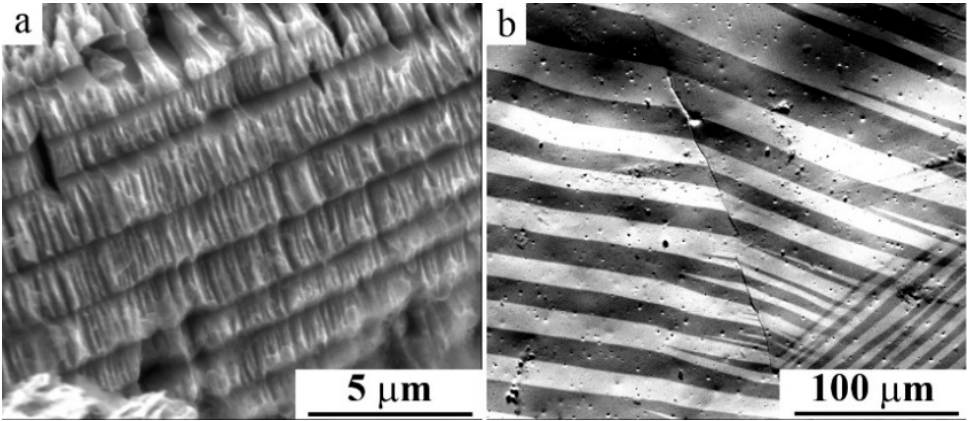
Figure 11. SEM images of ( a ) the packet twinned microstructure and ( b ) magnetic domain Figure11. SEMimagesof( a )thepackettwinnedmicrostructureand( b )magneticdomainmicrostructure microstructure of the alloy Ni 50 M n28.5 Ga 21.5 . of the alloy Ni 50 M n28.5 Ga 21.5 . Materials 2019 , 12 , x FOR PEER REVIEW 15 of 24